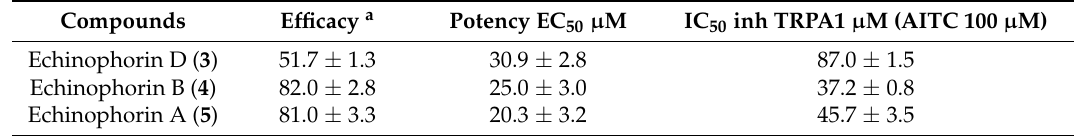
Table 2. Activity of compounds 3 – 5 on calcium influx in HEK293 cells transfected with rTRPA1. Compounds Efficacy